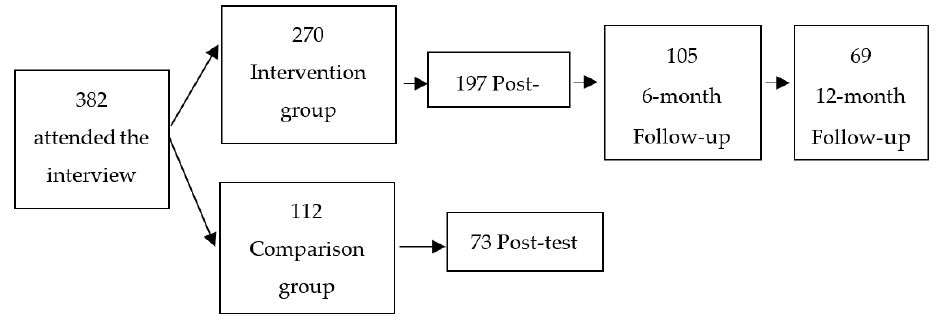
Figure 1. Participant flow chart.